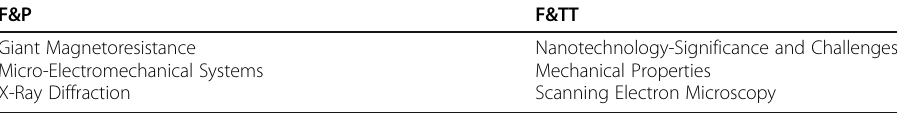
Nanotechnology-Significance and Challenges Mechanical Properties Scanning Electron Microscopy